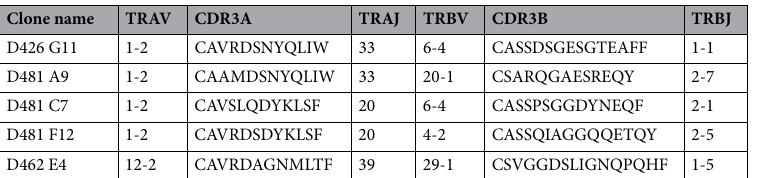
Table 1. TCR rearrangements and sequences for MR1T cell